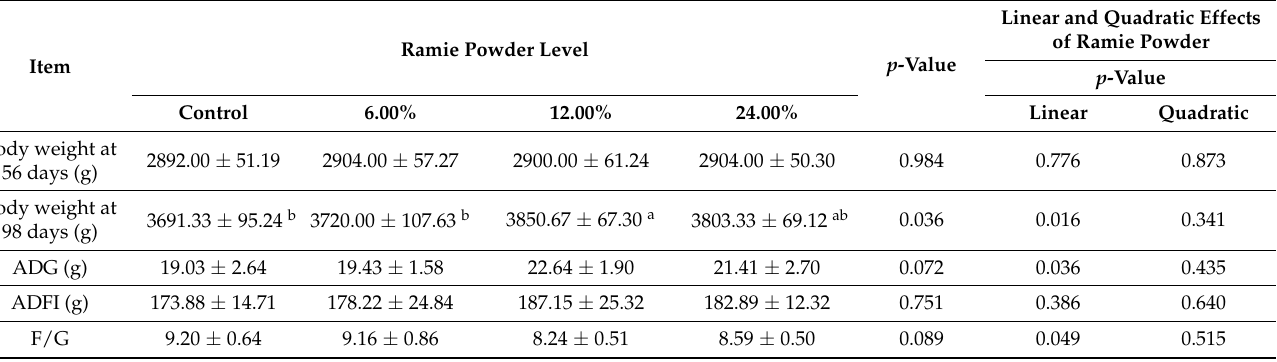
Table 2. Effect of different ramie powder levels in the diets on the growth performance of Yanling white geese (56–98 day).